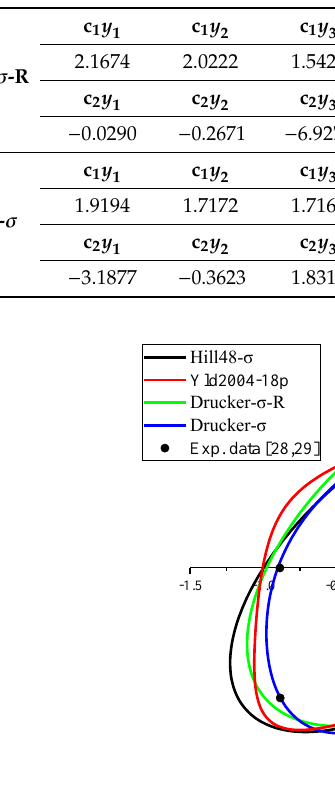
Table 7. Parameters of the extended Drucker yield functions for AA 2008-T4 sheet.